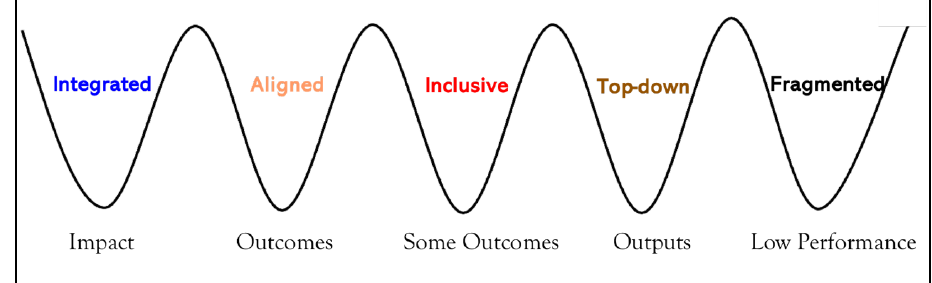
Figure 2. Simple attractor landscape for the Cooperative Capacity States with associated results.